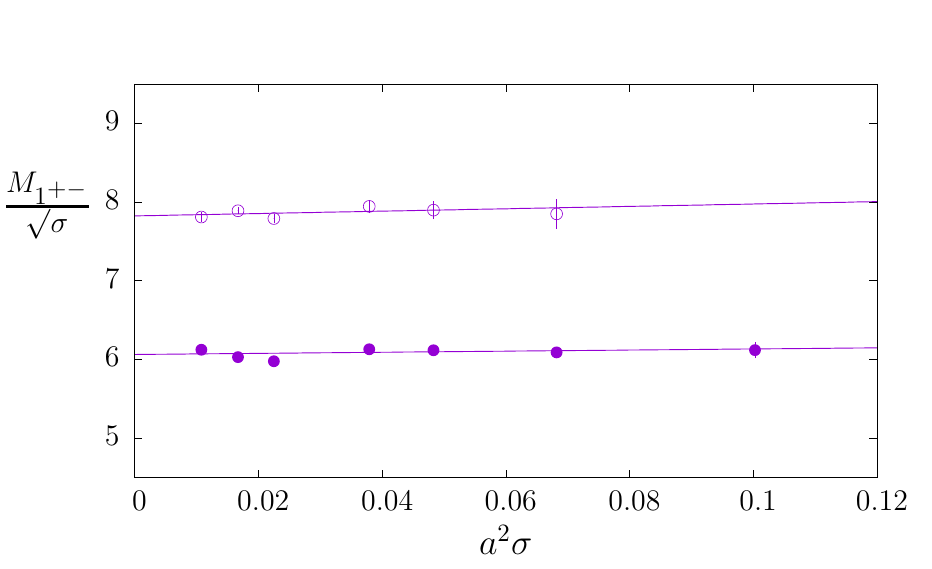
Figure 20 . Continuum extrapolation of the masses of the lightest and first excited J PC = 1 + − glueball states corresponding to the ground and second excited (triply degenerate) T 1 + −